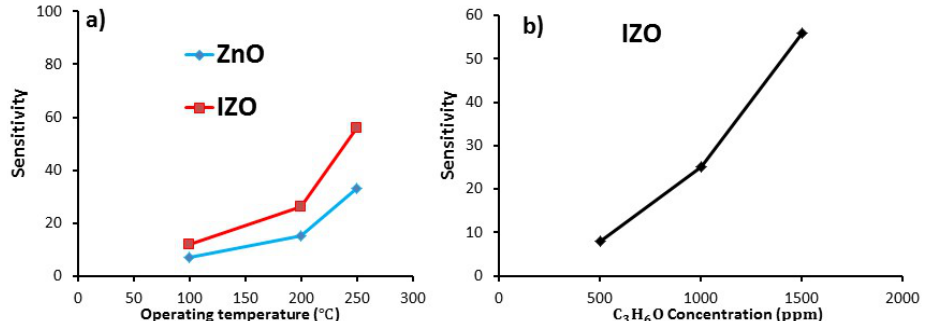
Fig. 6: (a) Sensitivity variation as a function of temperature (b) Sensitivity variation as a function of acetone concentration for ZnO:In sample at 250°C.